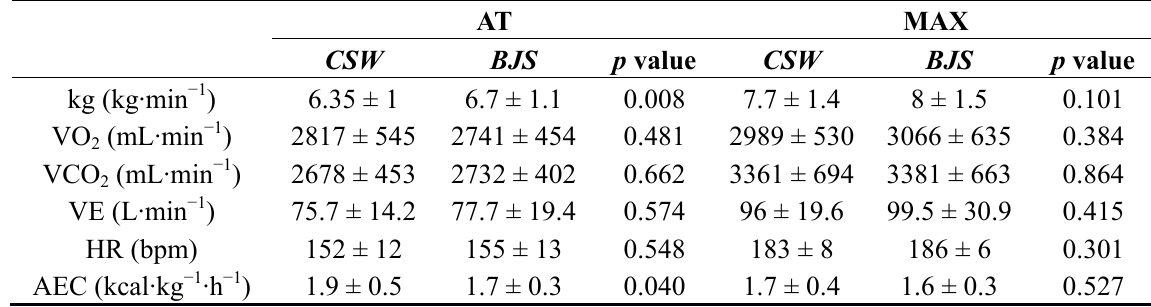
Table 2. variables’ level reached at anaerobic threshold (AT) and maximum workload (MAX) during the control swimming (CSW) and the beetroot juice supplementation test (BJS). Kg = workload, VO = oxygen uptake, VCO = carbon dioxide production, 2 2 VE = pulmonary ventilation, HR = heart rate, aerobic energy cost = AEC. AT MAX CSW BJS p value CSW